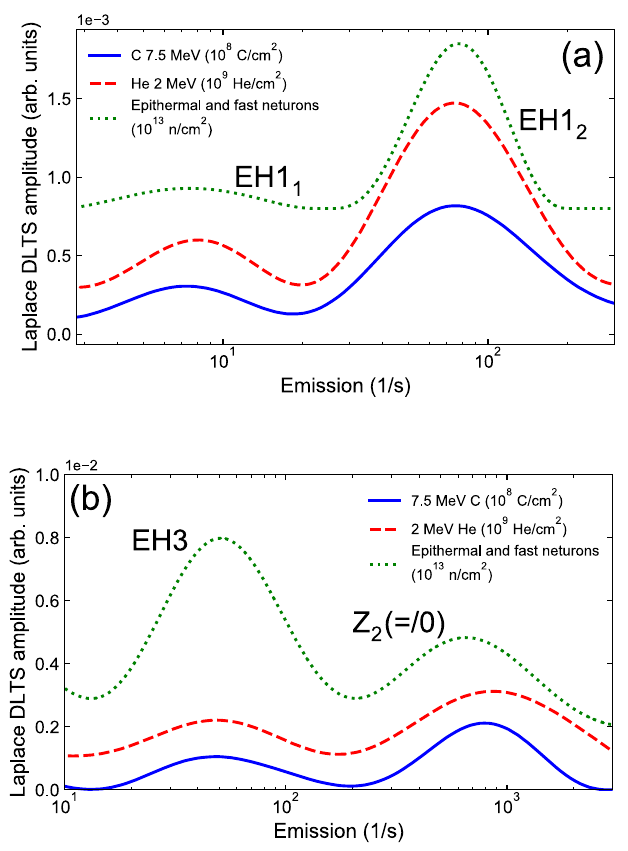
Figure 7. Laplace DLTS spectra of ion implanted and neutron irradiated SBDs at selected temperatures ( a ) 210 K and ( b ) 350 K. Pulse bias V P and pulse width t P are − 0.1 V and 10 ms, respectively. Reverse voltage V R for neutron irradiated SBD is − 10 V, while for ion implanted SBDs is − 5 V. The spectra are shifted vertically for clarity.